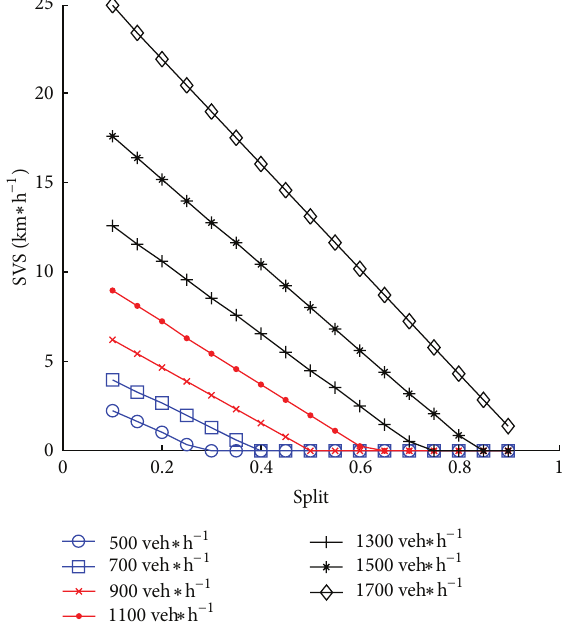
= 50 km/h, and 𝑤 𝑓